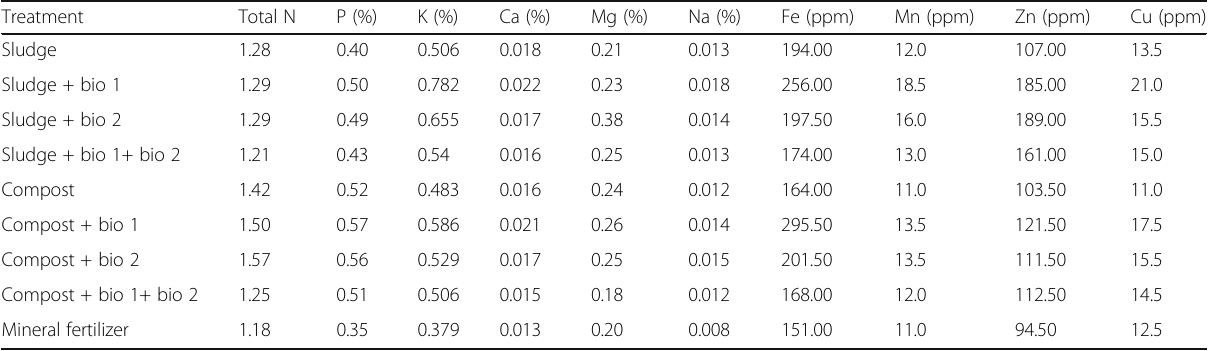
Table 4 Effect of compost, sludge, and biofertilizers on nutrient content of grain of wheat plants grown in newly reclaimed soil Treatment Total